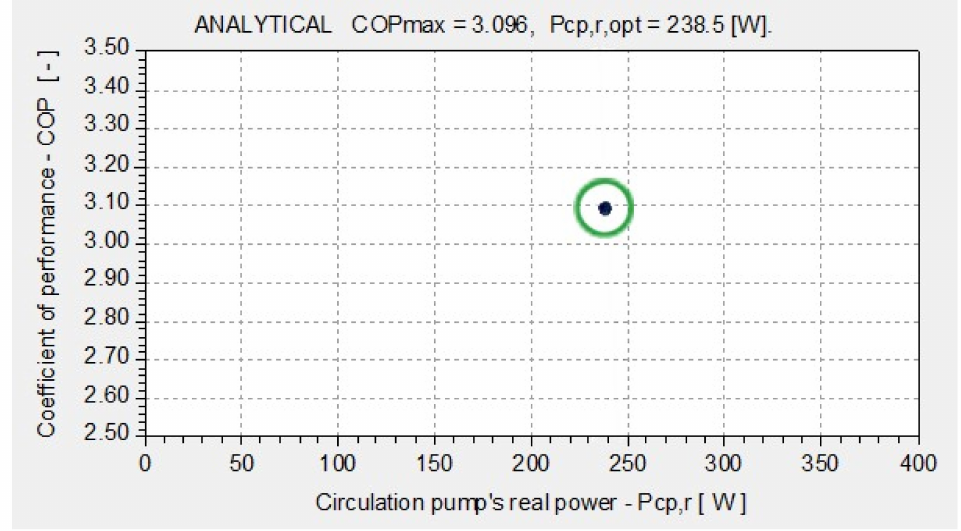
Figure 6. The solution obtained by the analytical-numerical optimization procedure. The point in the green circle presents the energy optimum of the heat pump heating system. According to the calculation COP c , max = 3.096, which is ensured by the optimal real power of the circulation pump, whose value is P cp , opt = 238.5 [ W ]